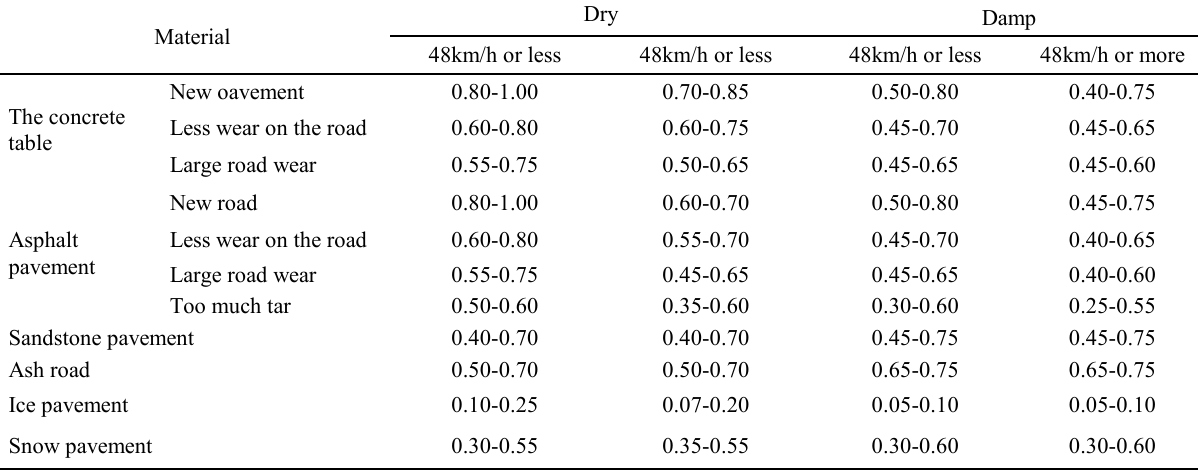
Table 1. Vehicle tire longitudinal friction coefficient reference value